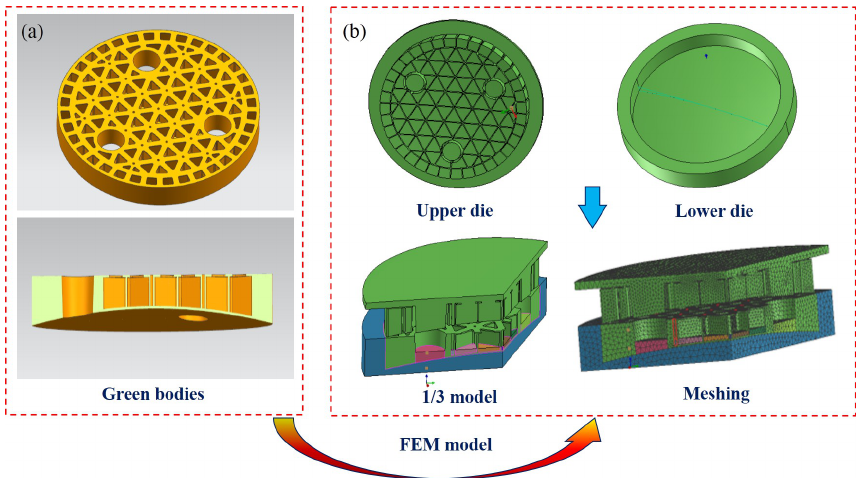
Figure 2. ( a ) 3D models of green bodies; ( b ) FEM